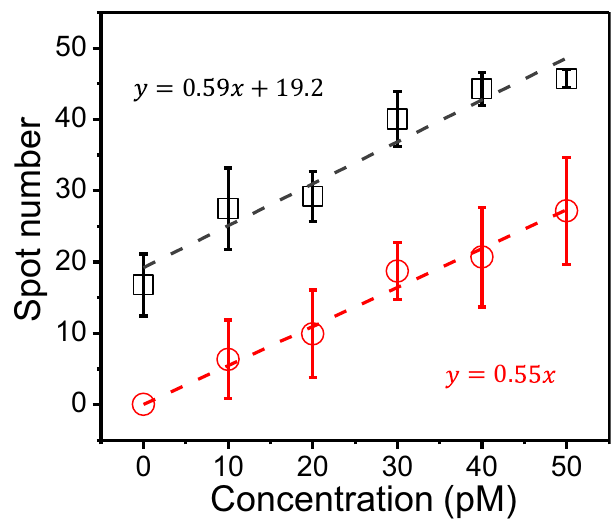
Fig. 3 Quanti fi cation of endogenous miRNAs. Varying amounts of synthetic let-7a were spiked in the total endogenous RNA of HeLa-S3 cell and the spot number was plotted as a function of spiked let-7a concentration (black squares). The same experiments were performed in a buffer without RNA as a control (red